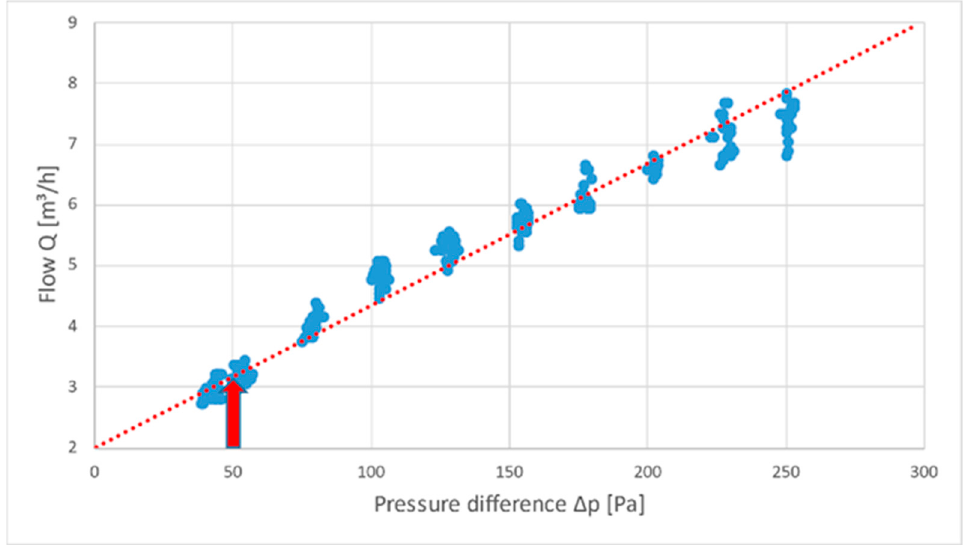
Figure 14. Linear regression graph for airtightness measurements of the 1st variant, Q 50 = 3.171 m 3 /h, q 50 = 1.300 m 3 /(m 2 .h). q 3 /(m 2 .h). 50 = 1.300 m